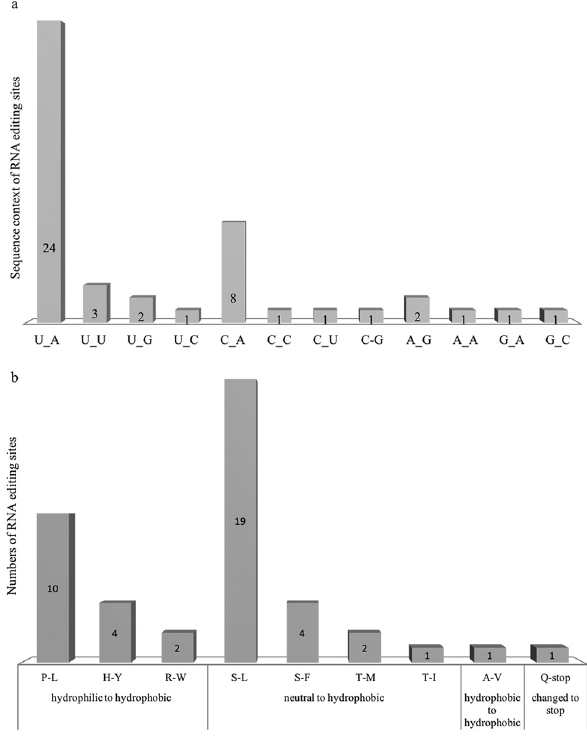
Figure 1 - The frequency of sequence contexts of RNA editing sites (a) and amino acid changes caused by RNA editing (b) in the chloroplast of B.